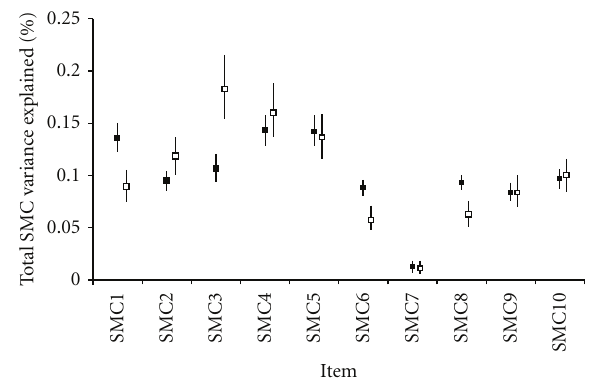
Figure 2: Percentage of the total subjective memory complaints scale (SMC) variance explained by each SMC item, controlling for depression score and education years. SMC: subjective memory complaints scale. Eta- squared values with 95% confidence intervals are shown. Black squares: community sample; open squares: clinical